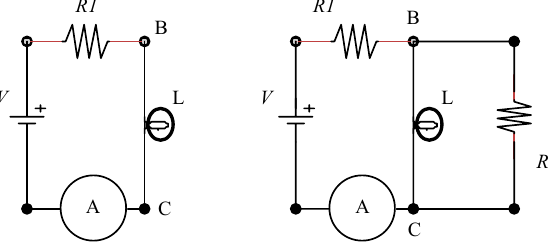
Fig. 4. The relationship (Ohm’s law) between potential difference, current and